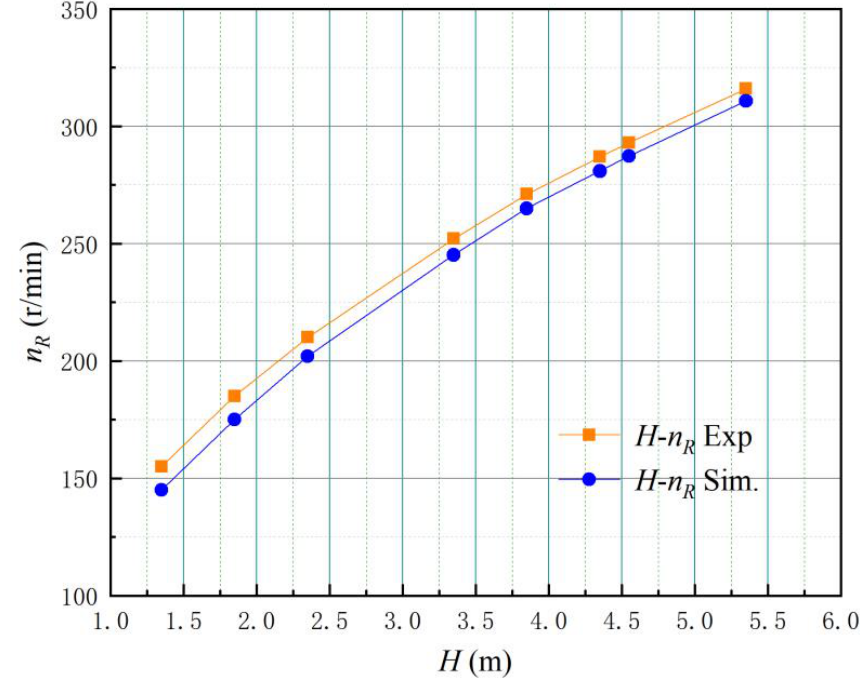
Figure 7. Runaway speed of pumps after being powered